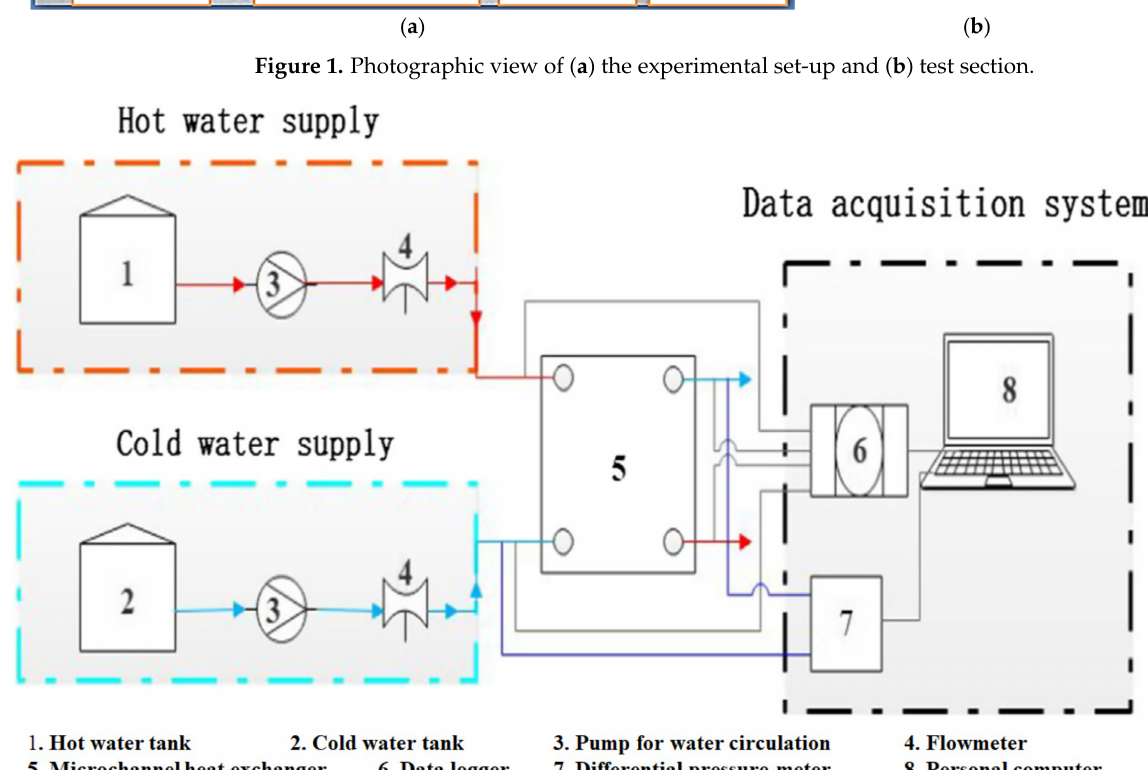
Figure 2. The schematic diagram of a flow